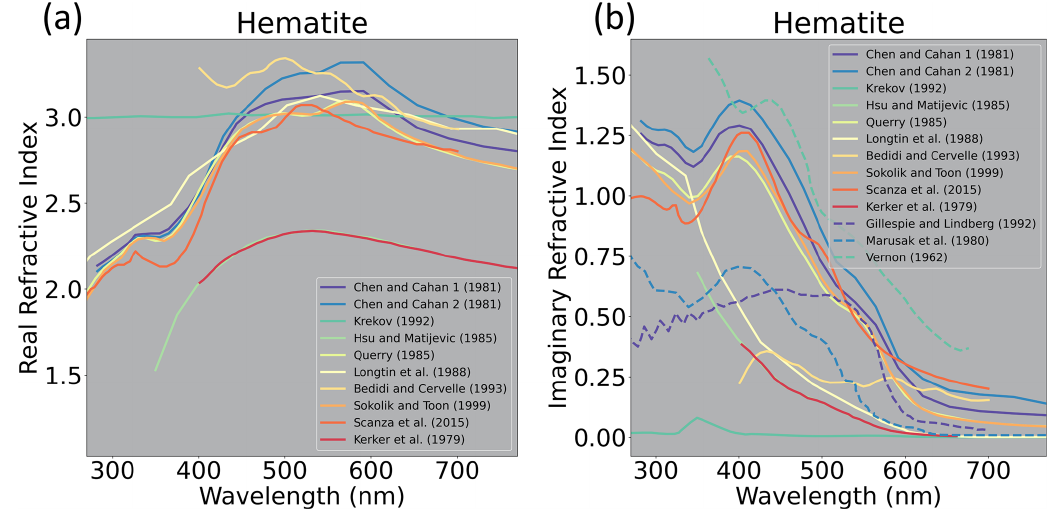
Figure 3. Plots of previously published hematite refractive indices at 300–700nm: (a) real part and (b) imaginary part. The reference information is also summarized in Table 1.